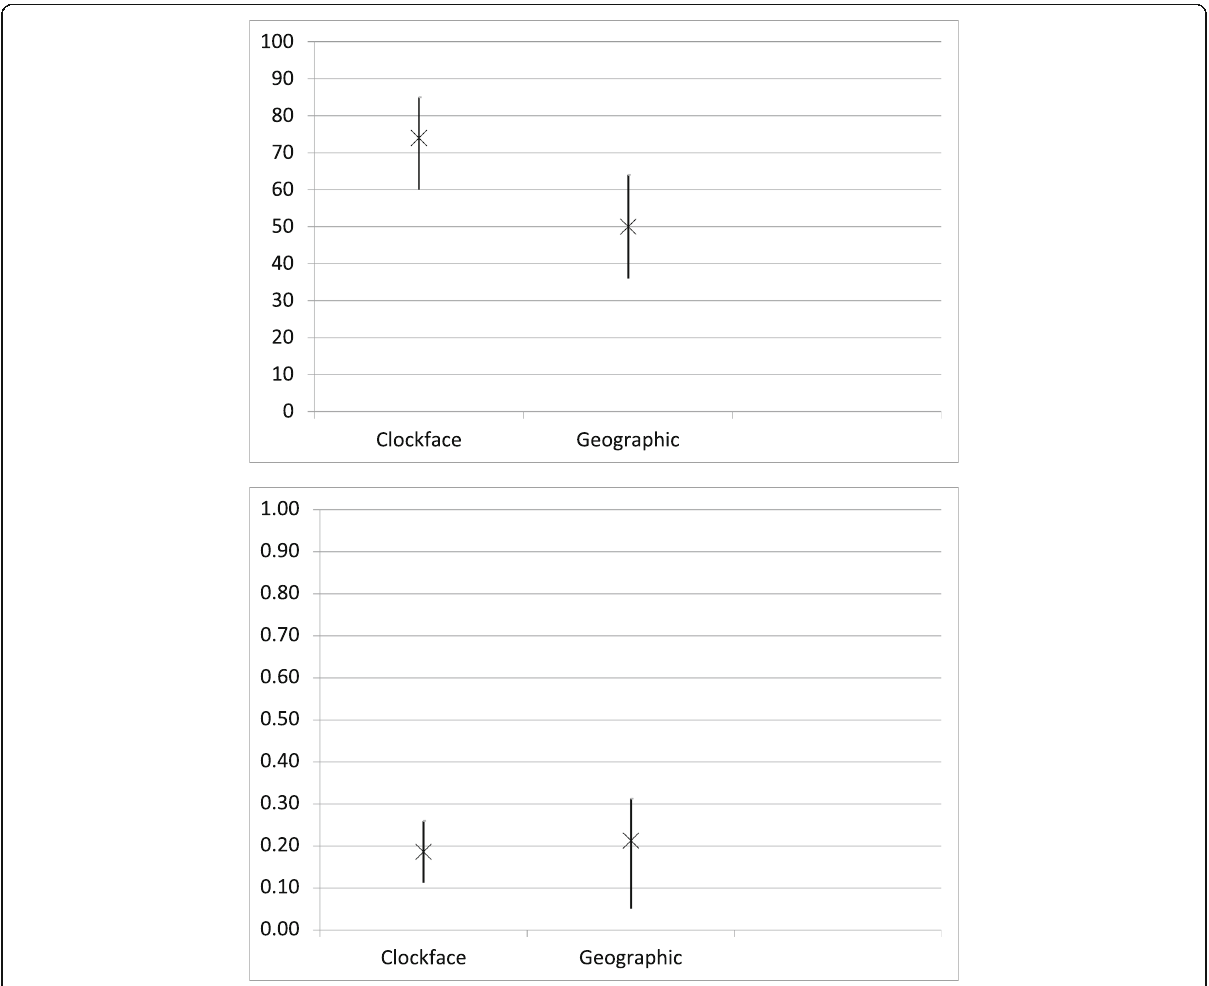
Fig. 4 Acetabular Labral Lesion Accuracy (top) and Interobserver reliability (bottom). X=accuracy (%) or kappa coefficient with 95% confidence